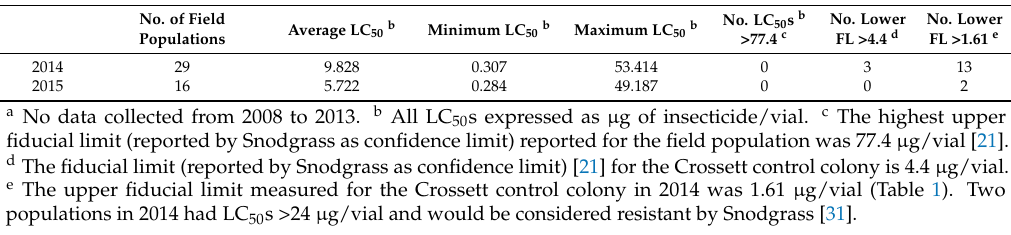
Table 4. Summary of annual responses of tarnished plant bug field population responses to permethrin a